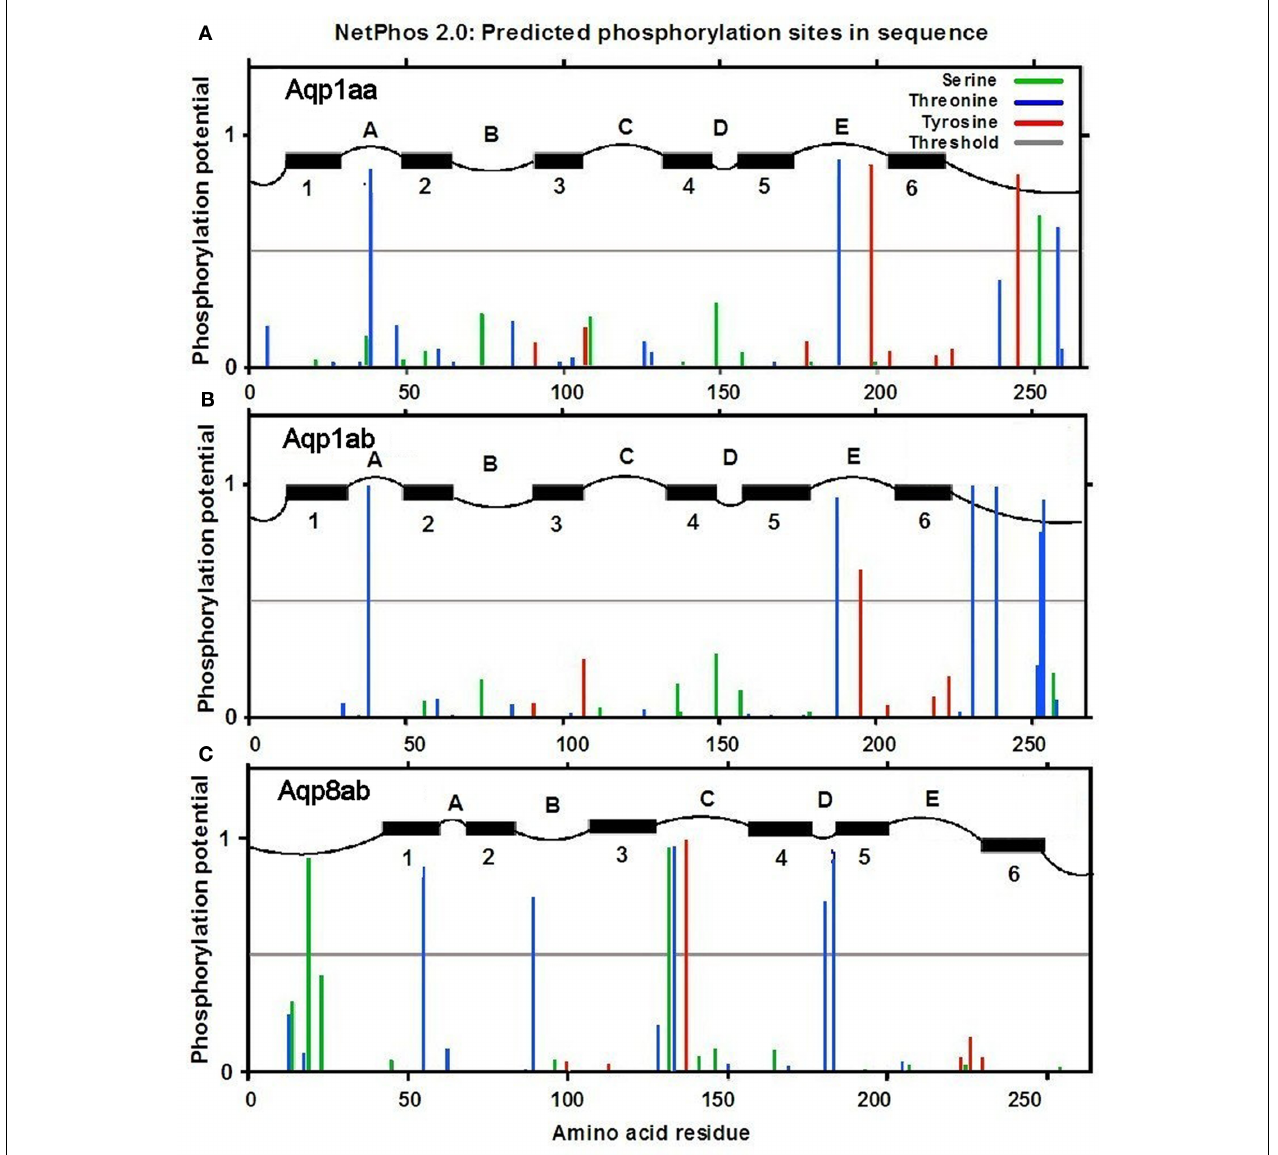
bars indicate predicted transmembrane domains with numbering below. Letters (A–E) indicate extracellular domains; letters (B–D) indicate cytosolic domains (fromTMPred at www.ch.embnet.org; Hofmann and Stoffel,